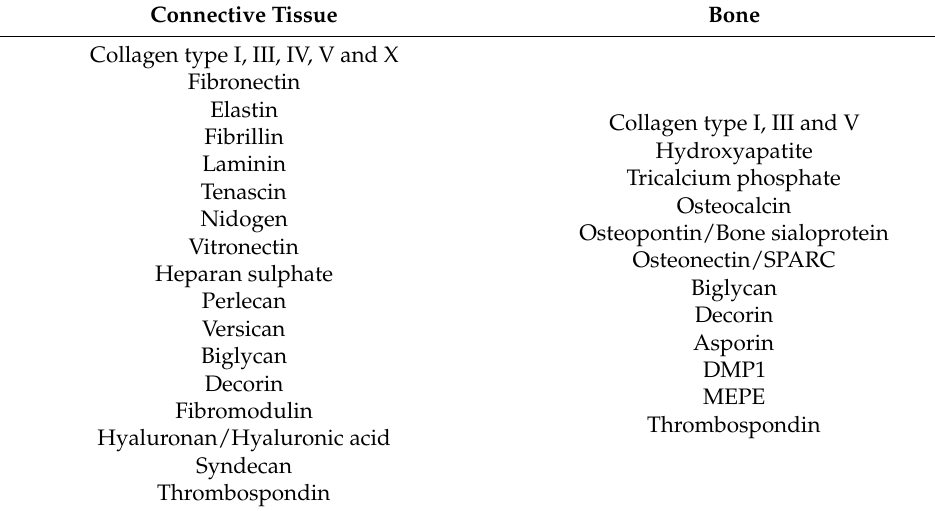
Table 1. ECM composition of connective tissue and bone. Connective